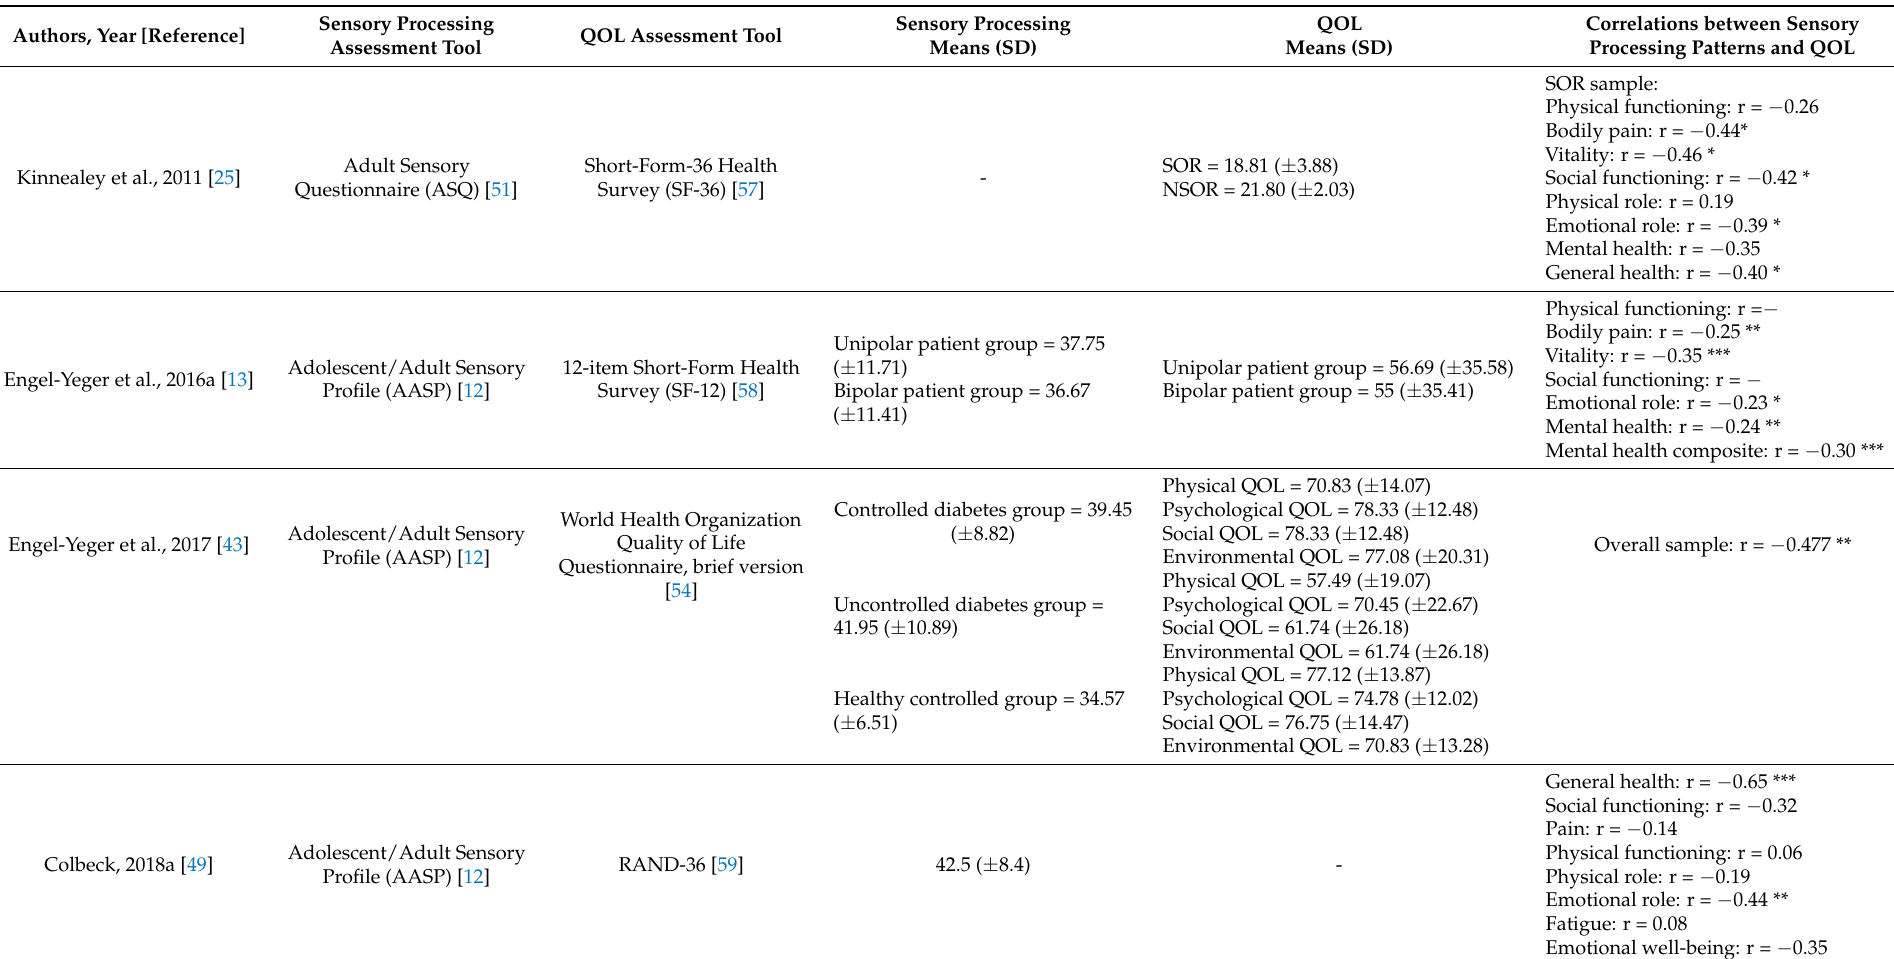
Table 3. Sensory processing (Dunn’s model) and QOL assessment tools, means and SD of sensory processing and QOL, and correlations between these